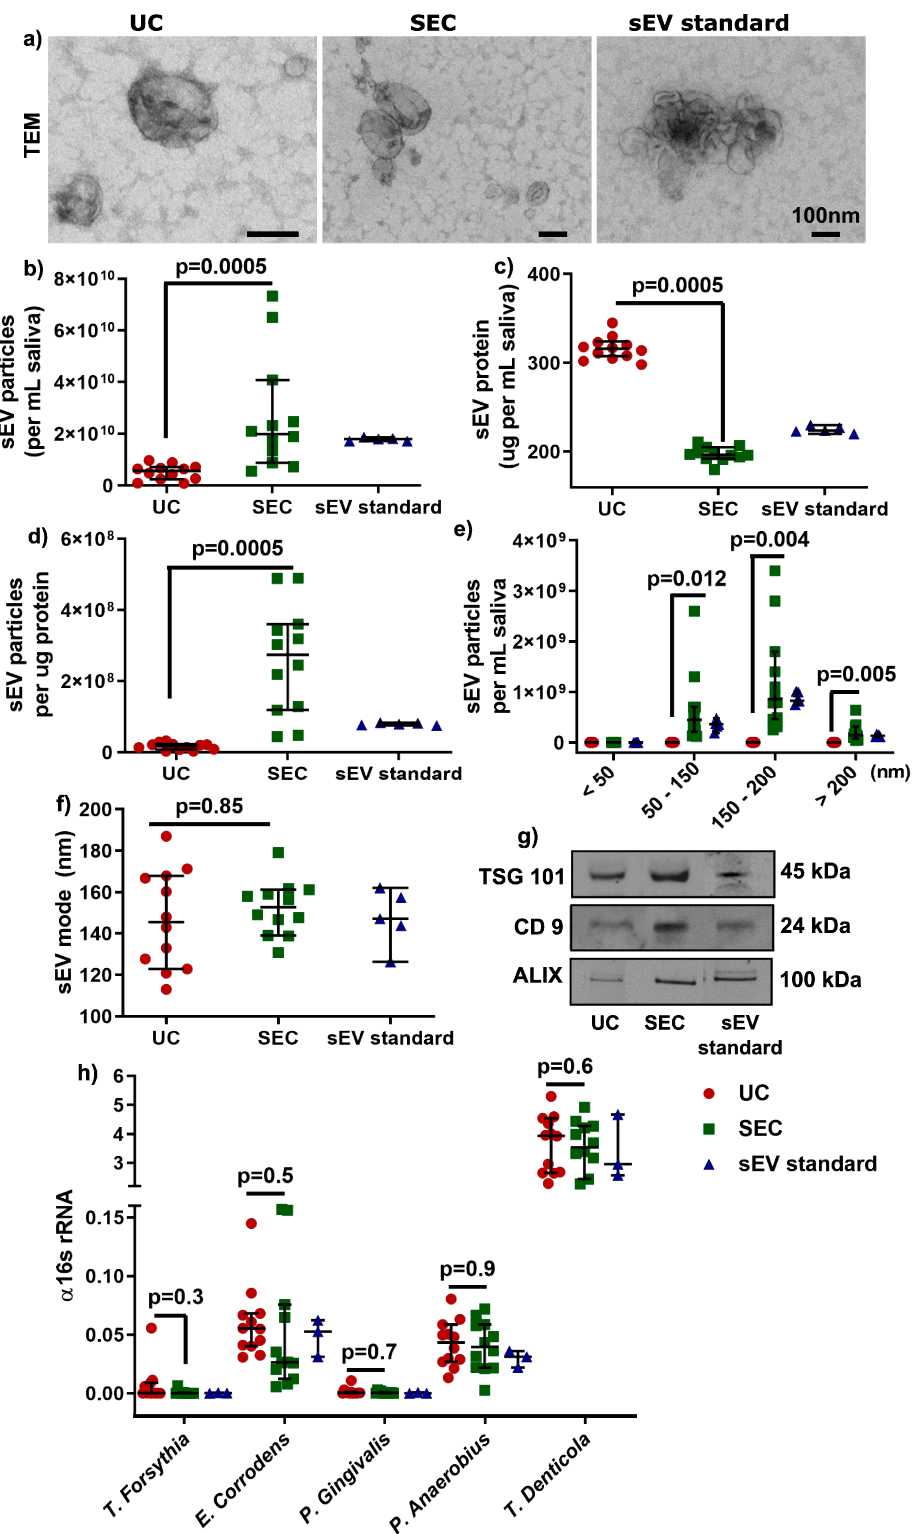
Figure 2. Characterization of salivary sEV by transmission electron microscopy (TEM) ( a ), NTA ( b – f